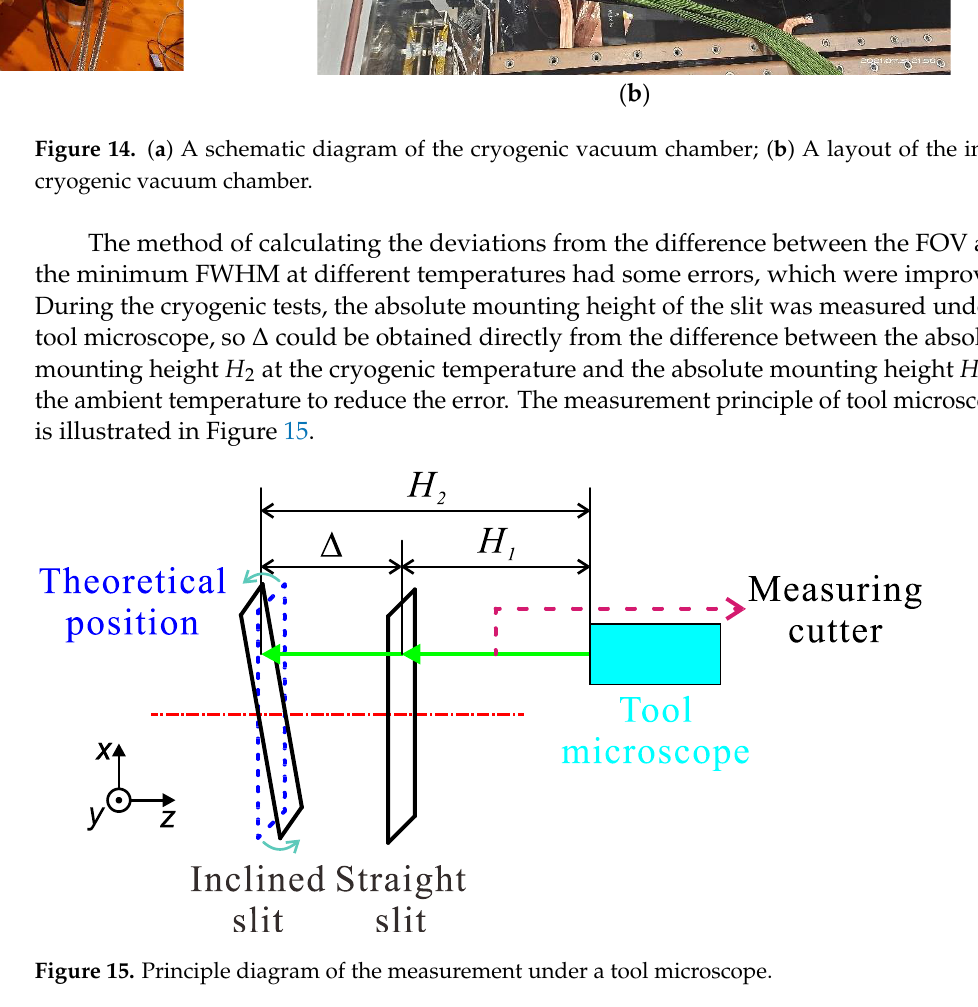
( b ) Figure 16. Imaging of the straight slit at 293 K. ( a ) a straight slit image; ( b ) the FWHM of the straight slit image. Subsequently, the slit shim was removed, and the slit was installed in the theoretical image position. The slit was tilted at 10° before the cryogenic vacuum chamber was opened to cool the spectrometer. After the temperature reached a steady state of 123 K, the spectrometer was continuously tested with the CO 2 laser. Figure 17 depicts the image